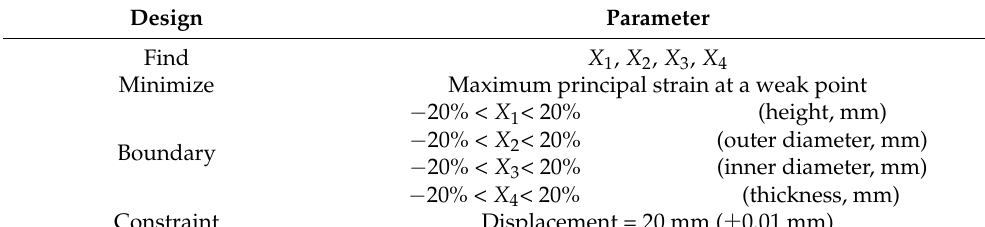
Table 5. Formulation of optimum design.